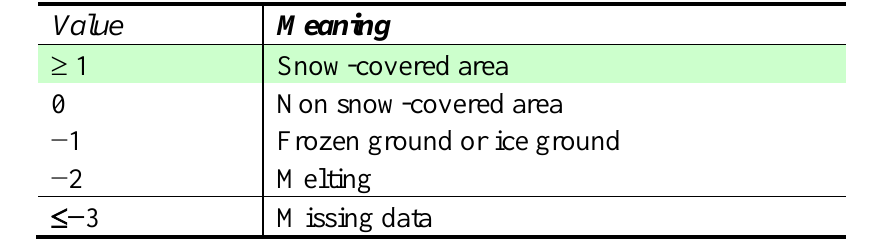
Table 2. Interpretation key for 8-day snow cover mapping derived from in situ measurements.